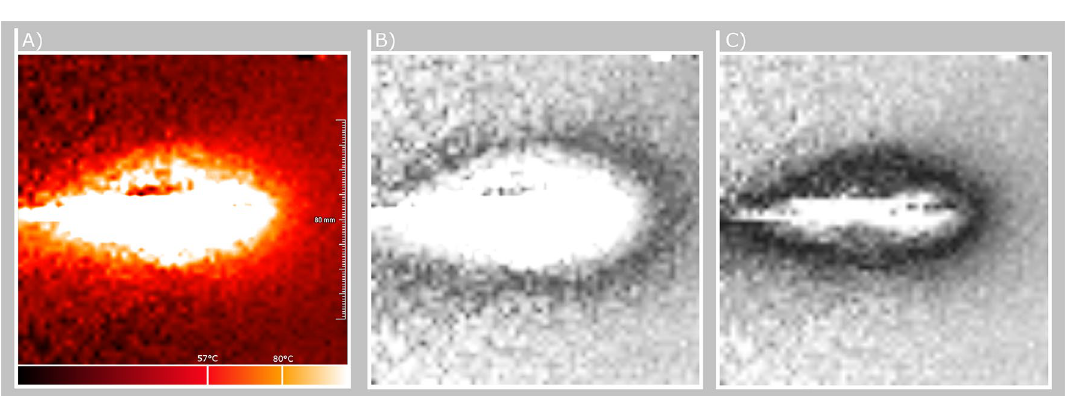
Figure 2. ( A ) Absolute temperature map. ( B ) Relative temperature cost map with a reference value of 25 ◦ C. Darker areas depict lower costs for the path finding algorithm. ( C ) Relative temperature map with a reference value of 35 ◦ C. Note how the black outline for lower path finding costs shifted and became more narrow due to the different reference